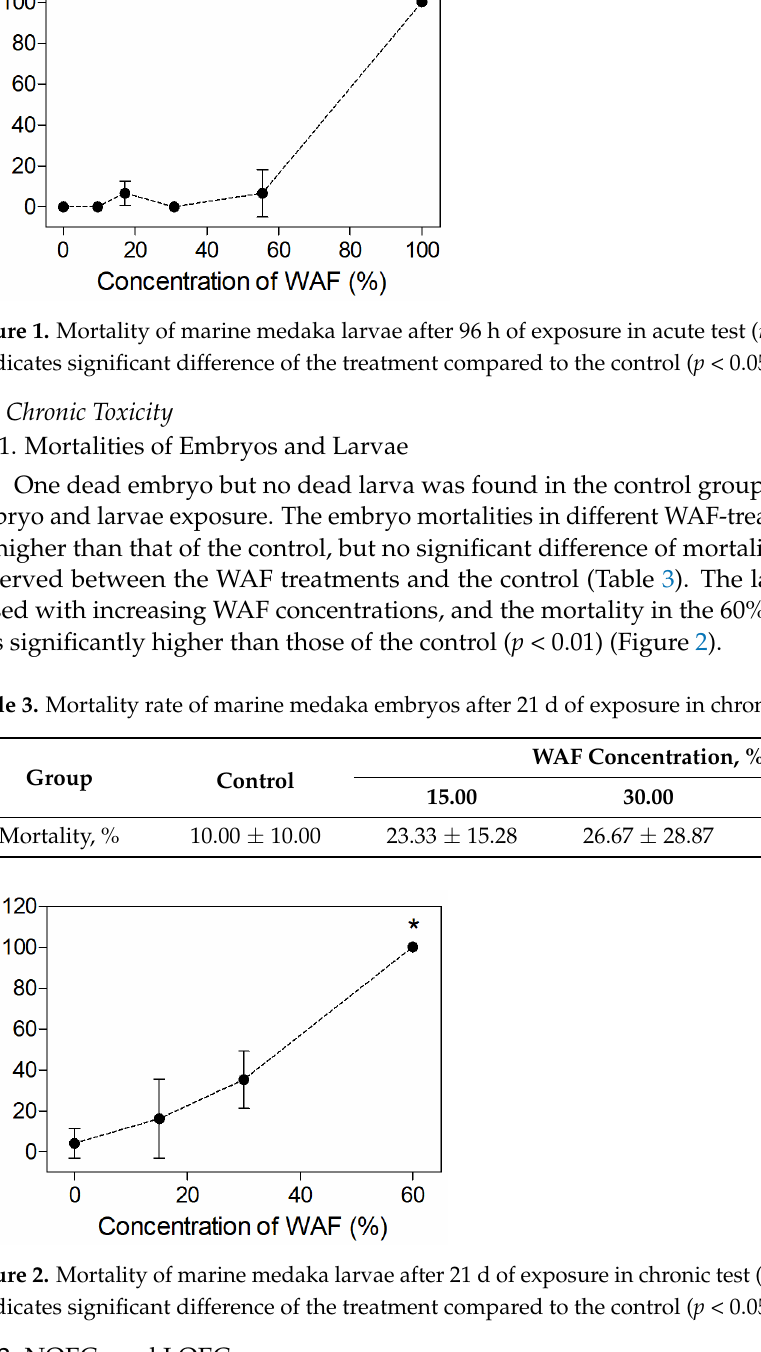
Table 4. NOECs and LOECs of different toxicity endpoints in chronic test. Life Stage